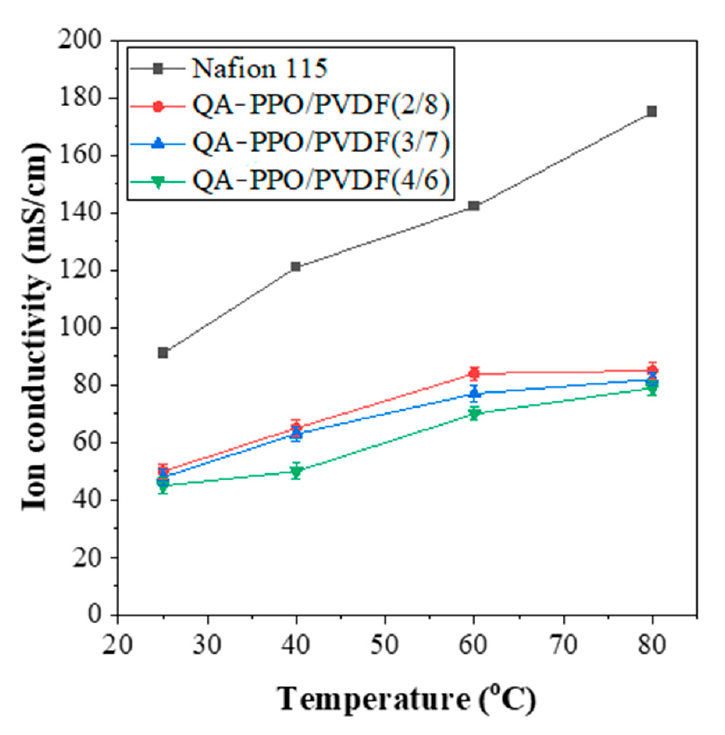
Figure 5. Ion conductivities of various BAEMs. Table 3. Hydroxide conductivity values of various BAEMs.